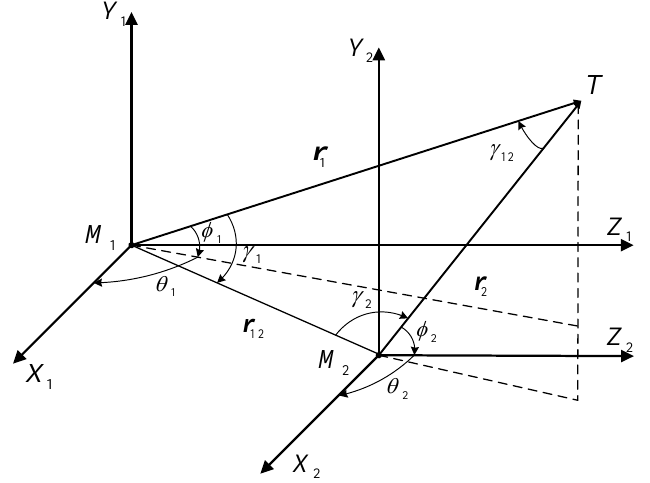
Figure 1. Three-dimensional engagement